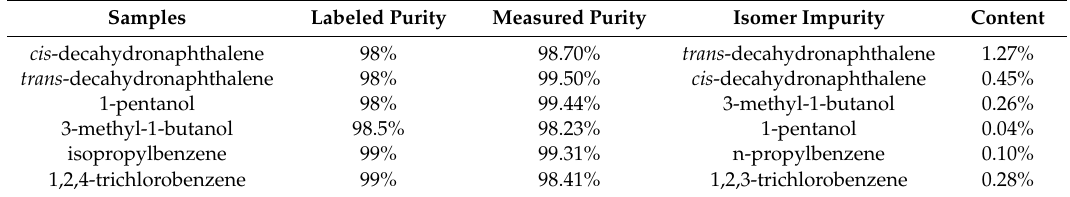
Table 3. Results for the detection of isomer impurities in the commercial reagent samples on PCL-PEG-PCL